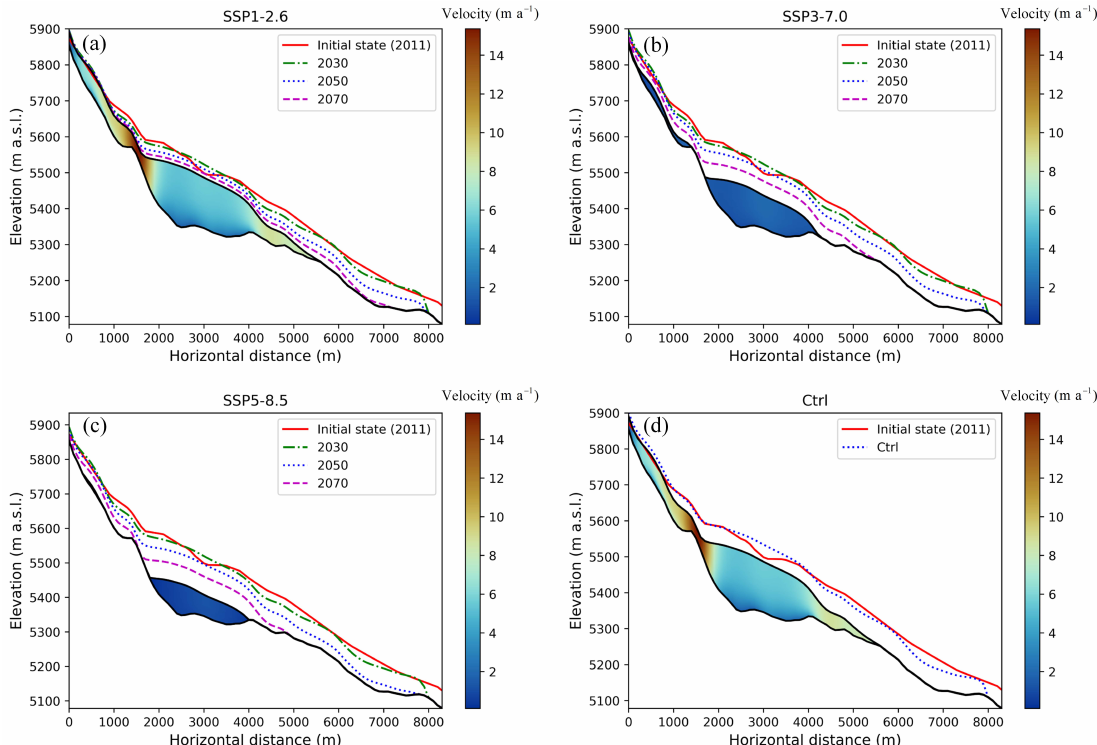
Figure 8. The evolution of JMYZG in 2100 under different climate scenarios. ( a ) SSP1-2.6, ( b ) SSP3-7.0, and ( c ) SSP5-8.5. ( d ) Control experiment keeping the SMB fixed. In ( a – c ), the red solid line, green dash-dotted line, blue dotted line, and magenta dashed line represent the simulated ice surface elevations in 2011, 2030, 2050, and 2070, respectively, and the black solid line represents the glacier geometry in 2100. In ( d ), the blue dotted line represents the simulated ice surface elevations in the control experiment in 2100; the rest of the lines are the same as in ( a ).